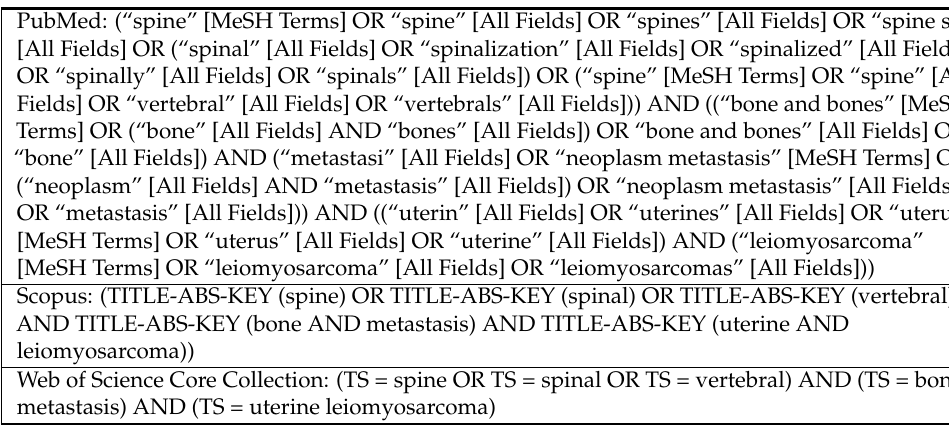
Table 1. Combination of free vocabulary and/or medical subject headings (MeSH) terms for the identification of studies in PubMed, Scopus, and the Web of Science Core